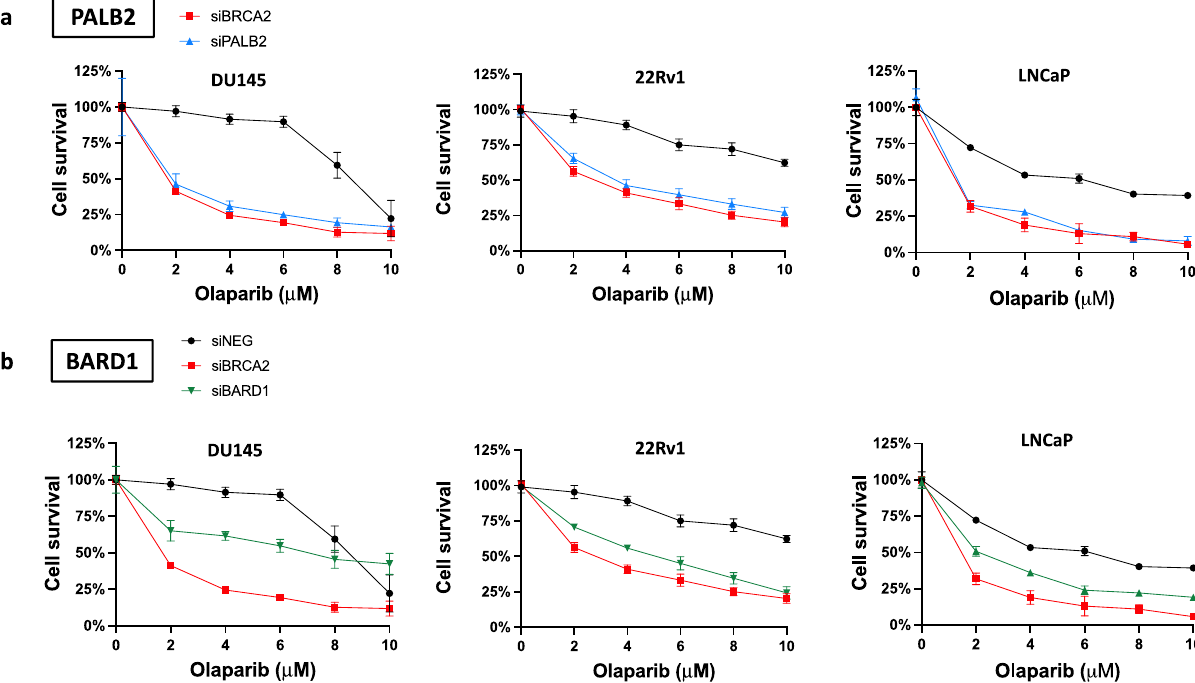
Fig. 3 PALB2 or BARD1 loss increases sensitivity to PARP inhibition in prostate cancer cells. a PALB2 depletion increases sensitivity to the PARP inhibitor olaparib across prostate cancer cell lines. b BARD1 depletion also increases olaparib sensitivity in prostate cancer cell lines. Data points and error bars represent the mean and standard deviation, respectively, of data collected from three